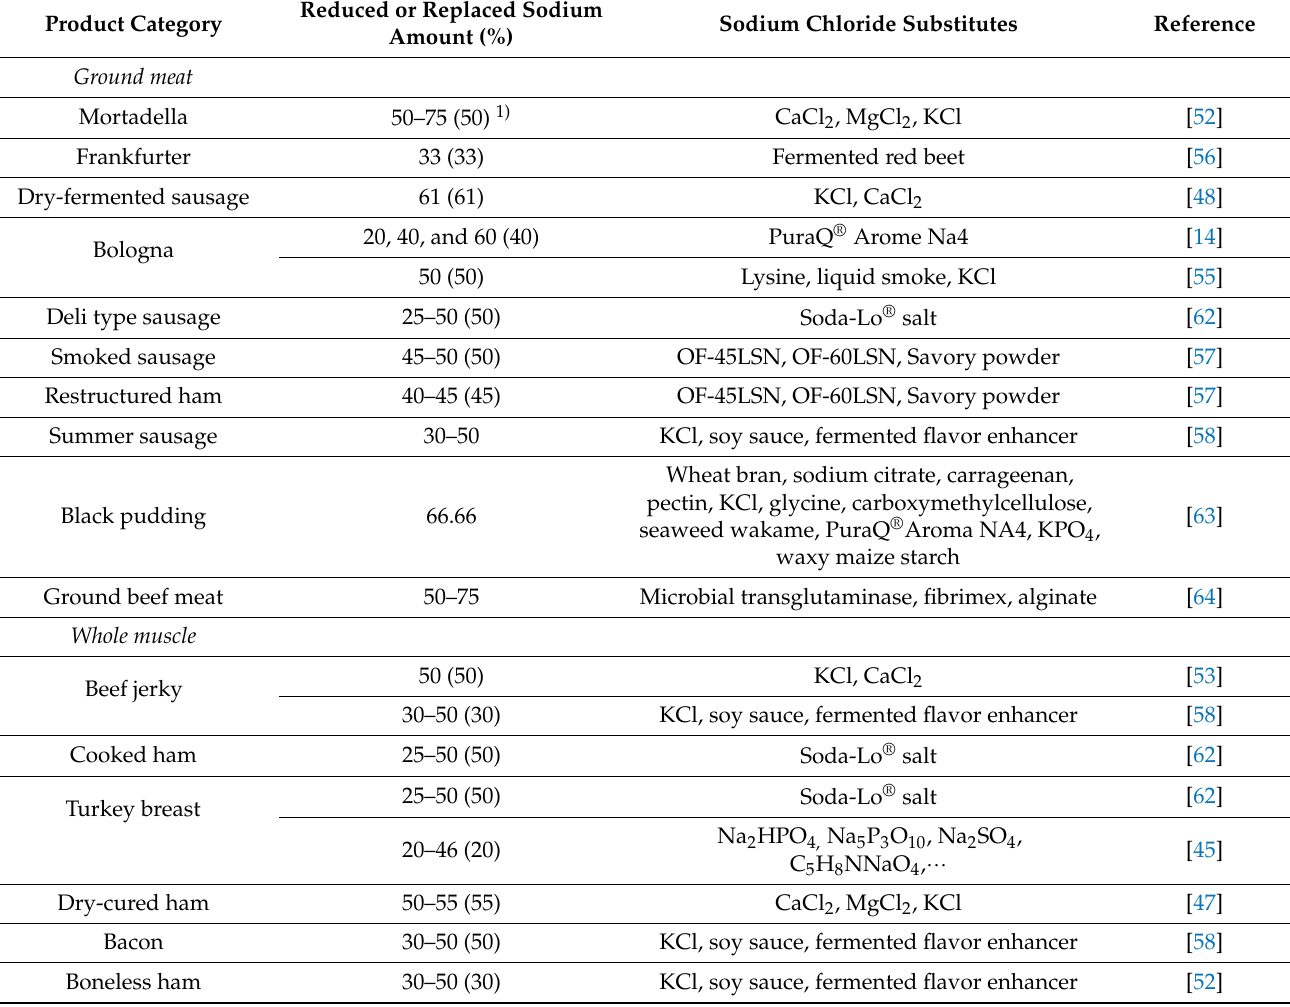
Table 2. Studies regarding the salt substitutes used for salt reduction in meat